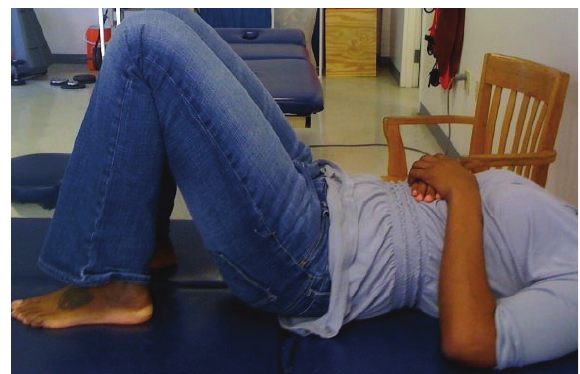
Figure 1: Rest position for